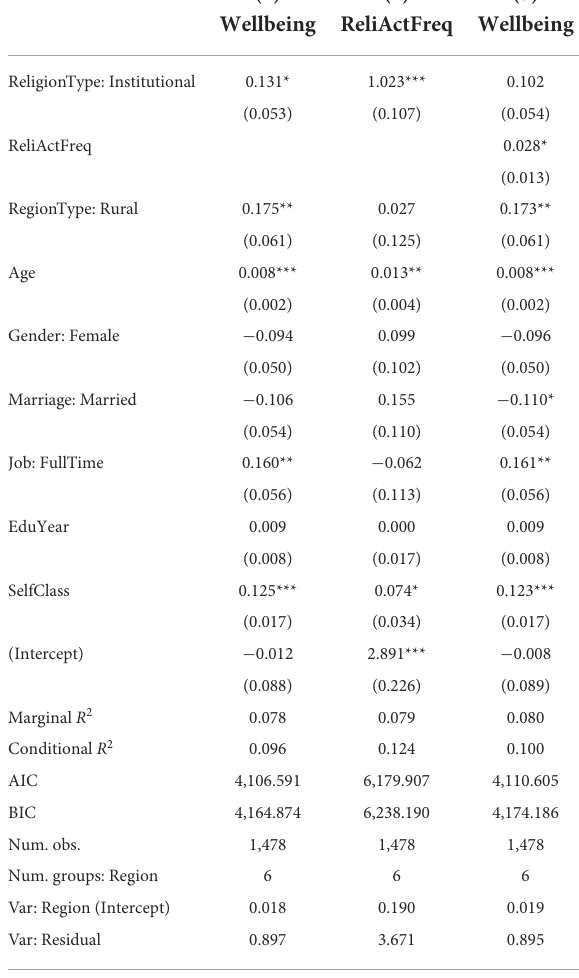
TABLE 1 Descriptive statistics of quantitative variables.